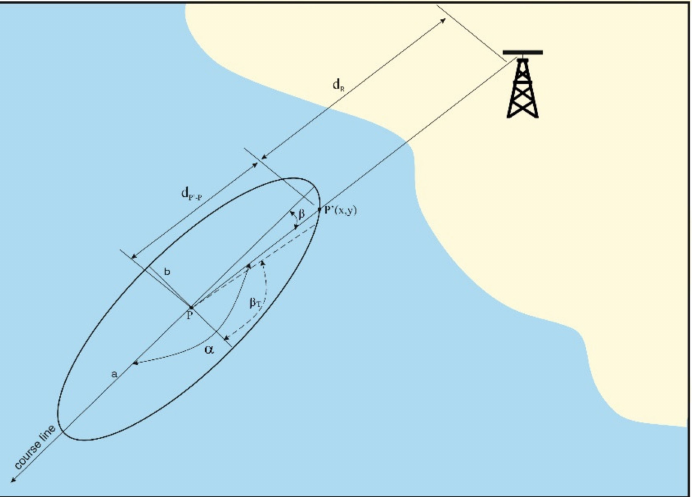
Figure 5. Measurement structure for the model wherein the radar beam falls on the stern of the